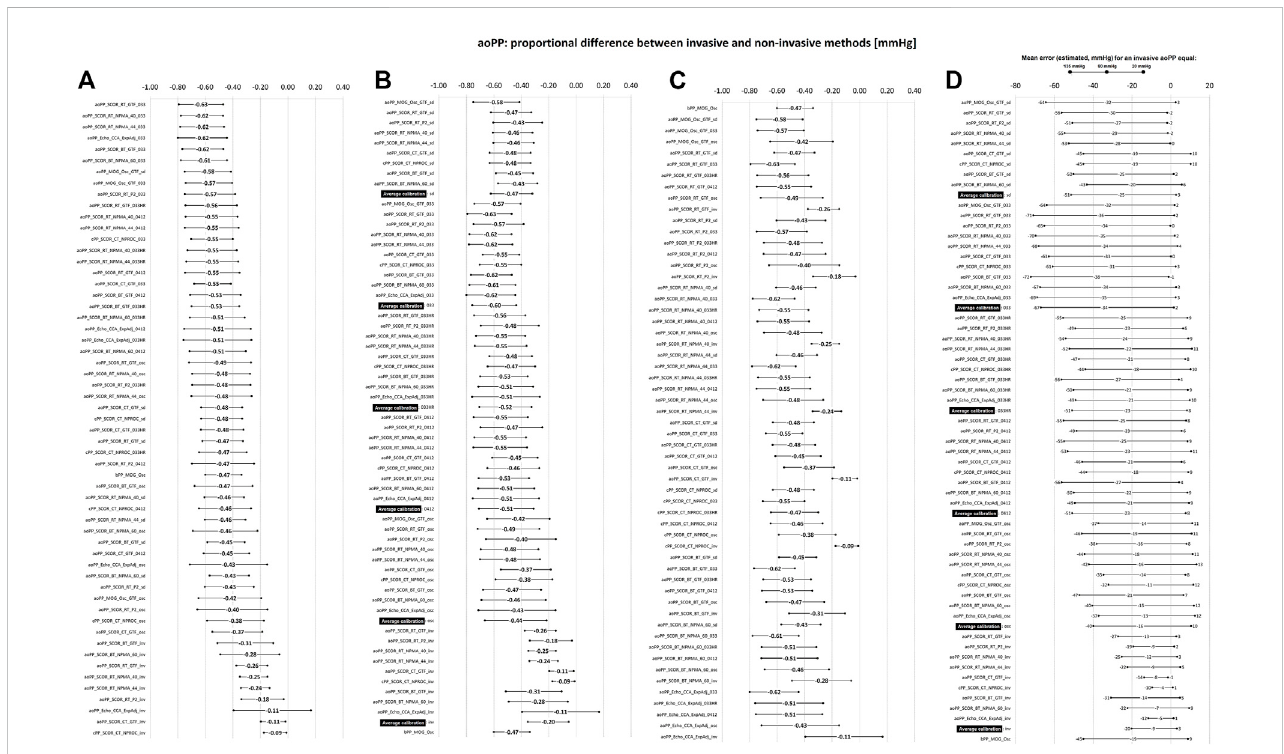
FIGURE 6 Bland-Altman derived proportional error (and 95% con fi dence interval) for comparisons between non-invasive and invasive aoPP measurements. (A) : ordered according to error level. (B) : ordered according to calibration scheme. (C) : ordered according to method used to obtaining aoPP value. (D) : error (in mmHg)betweennon-invasiveandinvasivemethodsatthreedifferentlevelsofinvasiveaoPP:20,80,and135 mmHg.Detailedquantitativeinformationabout Bland-Altman test was reported in Supplementary File S2 (Table